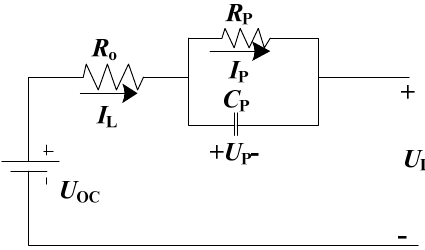
Figure 1. Schematic of the Thevenin